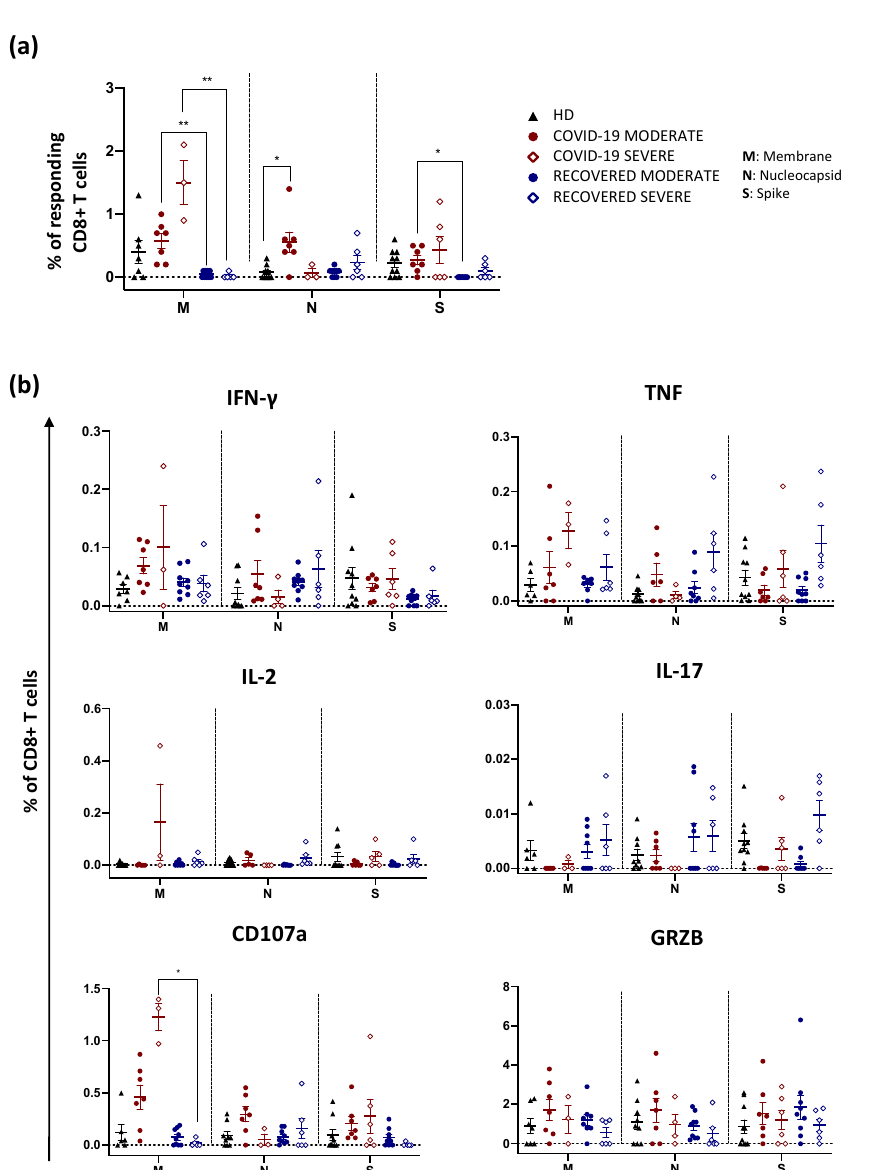
Figure 2. Total cytokine production by CD8+ T cells after in vitro stimulation. ( a ) Percentage of responding CD8+ T cells after stimulation with M, N or S. Data represent individual values from HD ( n = 10), COVID-19 moderate ( n = 7), COVID-19 severe ( n = 6), recovered moderate ( n = 9) and recovered severe ( n = 6). Mean (center bar) ± standard error of the mean (SEM, upper and lower bars) is represented. Statistical analysis was performed using Kruskal–Wallis non-parametric test corrected for multiple comparisons by controlling the False Discovery Rate (FDR), method of Benjamini and Hochberg. * q < 0.05; ** q < 0.01. Background was subtracted from each sample. ( b ) Representation of the total production of cytokines after stimulation of CD8+ T cells. We evaluated the percentage of CD8+ T cells producing IFN- γ , TNF, IL-2, IL-17, GRZB as well as expressing CD107a among HD ( n = 10), COVID-19 moderate ( n = 7), COVID-19 severe ( n = 6), recovered moderate ( n = 9) and recovered severe ( n = 6). Data are represented as individual values, mean (center bar) ± standard error of the mean (SEM, upper and lower bars) is represented. Statistical analysis was performed using Kruskal–Wallis non-parametric test corrected for multiple comparisons by controlling the False Discovery Rate (FDR), method of Benjamini and Hochberg. * q < 0.05. Background (i.e., the value determined in unstimulated controls) was subtracted from each sample.